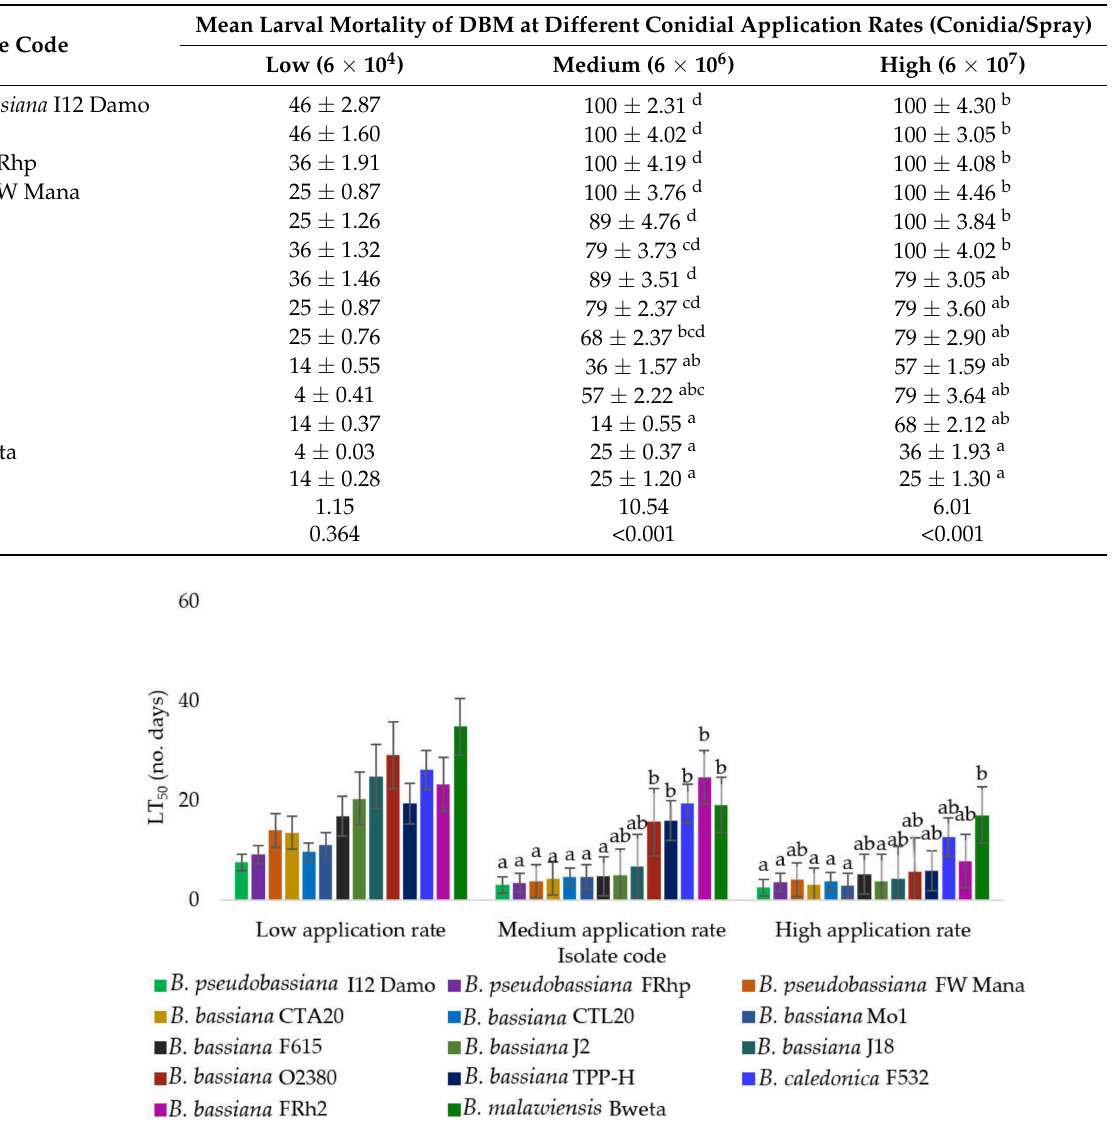
Table 2. Larval mortality (% ± SE) of diamondback moth (DBM) seven days after application of selected Beauveria isolates at three conidial mortality rates was corrected against the control mortality rate using Abbott’s formula. Values in a column followed by the same letter are not significantly different ( p > 0.05) according to Tukey’s HSD test.